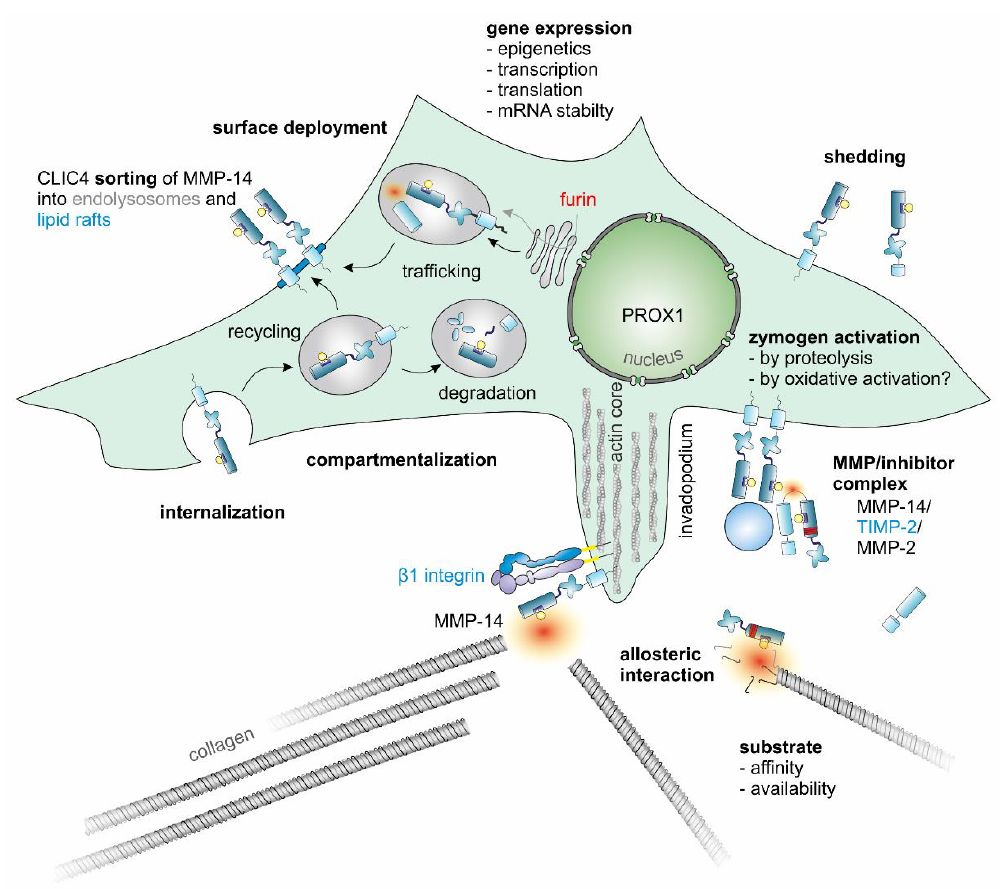
Figure 5. The enzymatic activity of MMP-14 is subject to complex regulation. Its gene expression is controlled by epigenetic and transcriptional factors, notably the transcription factor PROX1. In addition, MMP-14 is regulated by cotranslational removal of its signal peptide in the endoplasmic reticulum, the cleavage of its autoinhibitory prodomain in the Golgi apparatus by furin, and at the post-transcriptional level by O-glycosylation of protease-sensitive linker regions and phosphorylation and palmitoylation of its cytoplasmic domain [12].